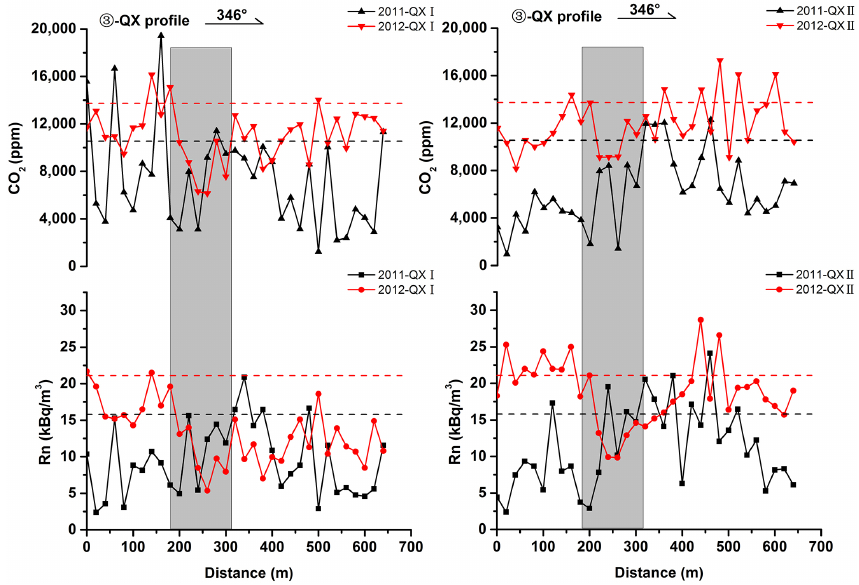
Figure 6. Rn and CO 2 concentrations along the QX profile across the Xiadian Fault. The shaded bar represents the location of the fault. The black and red dotted lines represent the anomaly threshold of soil gas in 2011 and 2012, respectively. The arrow at the top (with number above) represents the direction of the profile.